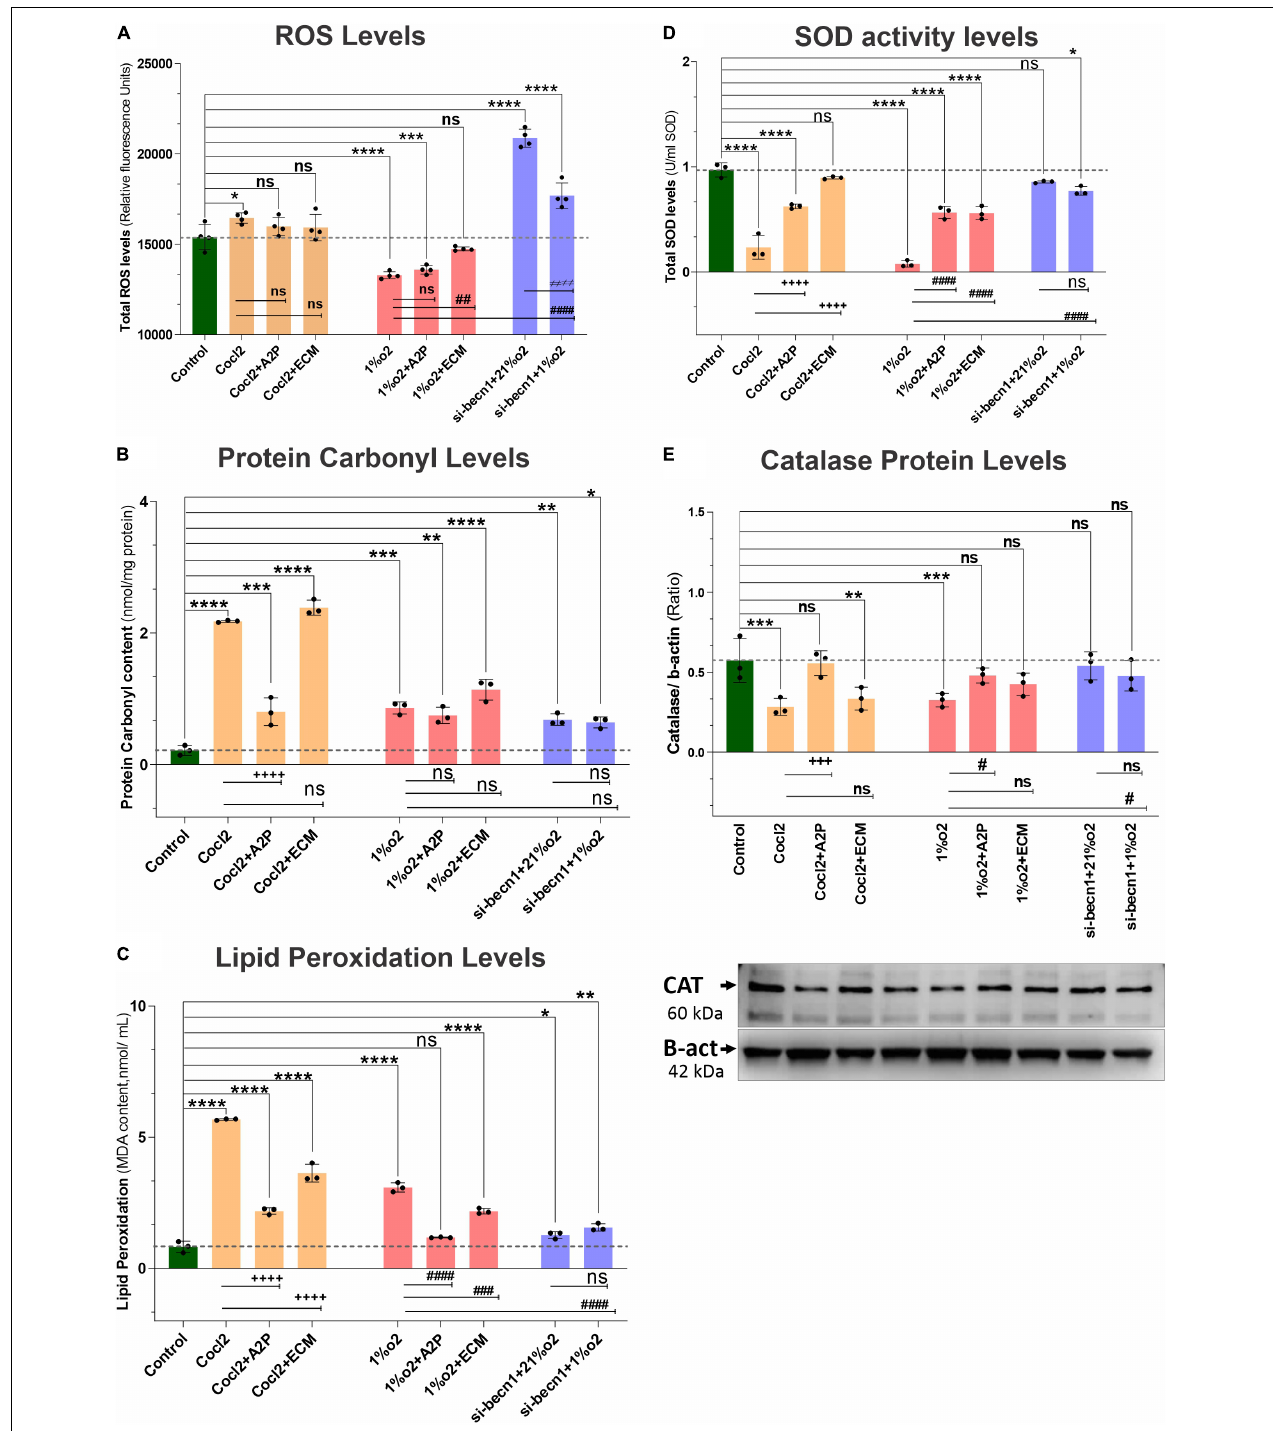
FIGURE 6 | Hypoxia, Cocl2 exposure, and Beclin1 inhibition markedly alter the H9c2 cells oxidative stress and antioxidant levels. The graphs indicate oxidative stress markers (A) Total ROS levels, (B) Protein Carbonyl levels, (C) Lipid Peroxidation levels, (D) antioxidant marker SOD activity levels, and (E) Catalase Protein levels in H9c2 cells treated with ECM, A2P, siRNA-Beclin1 and grown under CoCl2, Hypoxia (1%O2) and Normoxia conditions (21%O2). Total- ROS levels decreased in hypoxia (1%O2) exposed cells (**** p < 0.000), 1%O2 + A2P (**** p < 0.0001), and not significantly changed in 1%O2 + ECM treated cells ( ns p < 0.267). Cocl2 exposure (* p < 0.022) and Beclin-1 inhibition increased the total- ROS levels both in normoxia (21%O2), **** p < 0.0001, and in hypoxia (1%O2) **** p < 0.0001 cells, and not changed in Cocl2 + A2P, Cocl2 + ECM exposed cells. However, compared to Hypoxia cells ROS levels, 1%O2 + ECM cells ROS levels was increased significantly ( ## p < 0.001) and not changed in all other experimental groups. Protein carbonyl content, and Lipid peroxidation levels were increased